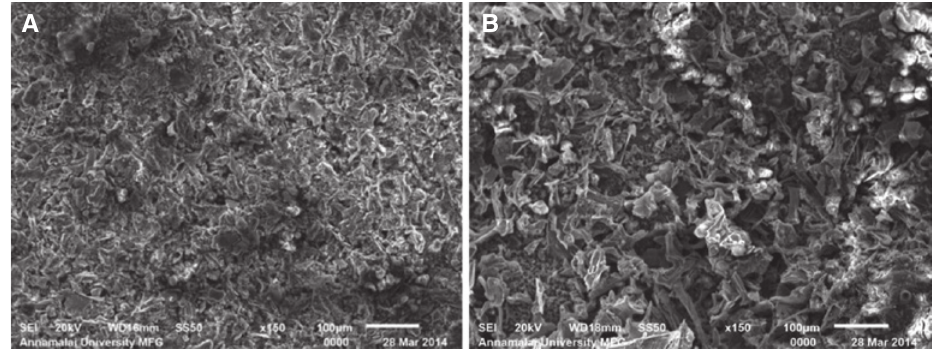
C/Gr (A) with abrasive and (B) without abrasive. Reproduced with permission from Elsevier Figure 6: ECM surface of Al6061/B 4 ( ScienceDirect)